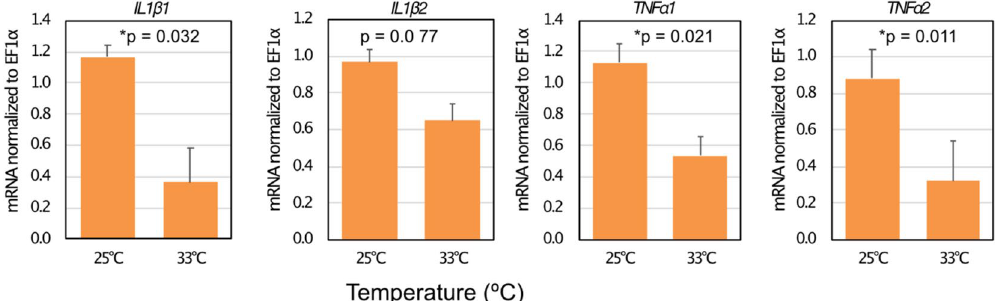
Figure 7. Temperature sensitivity of the ex vivo function of the eye-sac cells. Eye-sac cells, collected from three ◦ ◦ bubble-eye goldfish were cultured either at 25 C or 33 C. Gene expressions of pro-inflammatory cytokines in the presence of heat-killed P. aeruginosa cells (four hours after adding of the Pseudomonas cells) are shown in the figure. The values were normalized to EF1α. P values obtained from Student’s t-tests are shown in the figure. The asterisks represent statistically significant differences (significance levels were corrected by Benjamini– Hochberg